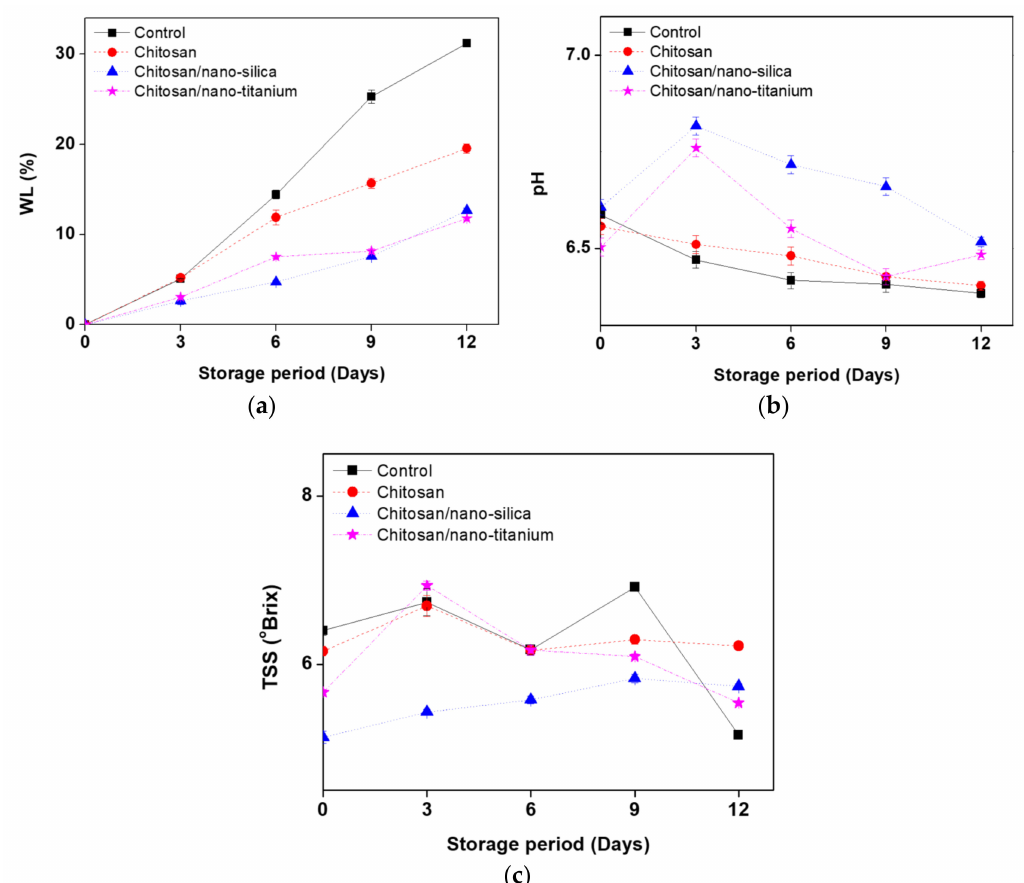
Figure 1. Effects of nano-films on Weight loss (WL) ( a ), acidity (pH) ( b ), and total soluble solid concentrations (TSS) ( c ) for white button mushrooms during storage at 4 ◦ C for 12 days. Data are mean ± SD, n =